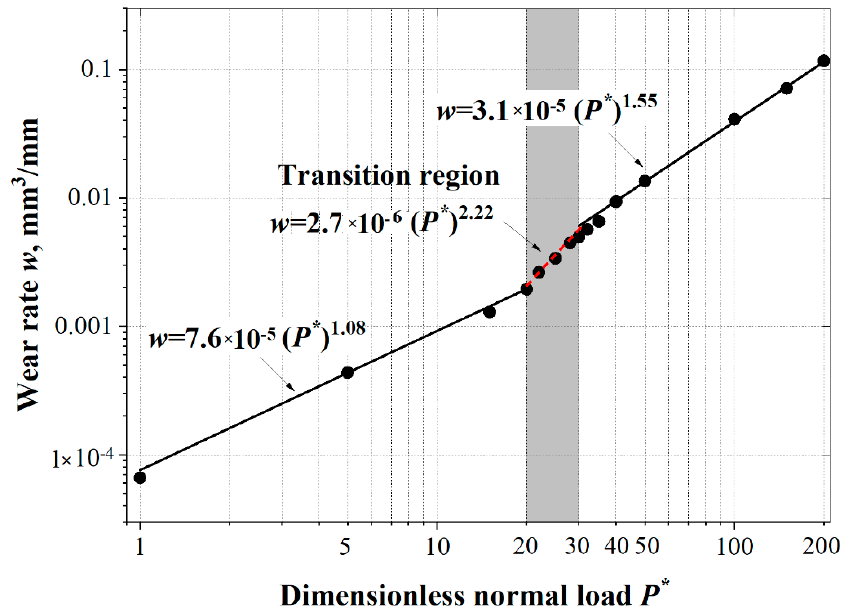
Figure 2. The effect of dimensionless normal load on wear rate. The mild and severe wear regimes and the transition region between them are found. Taken from [49].